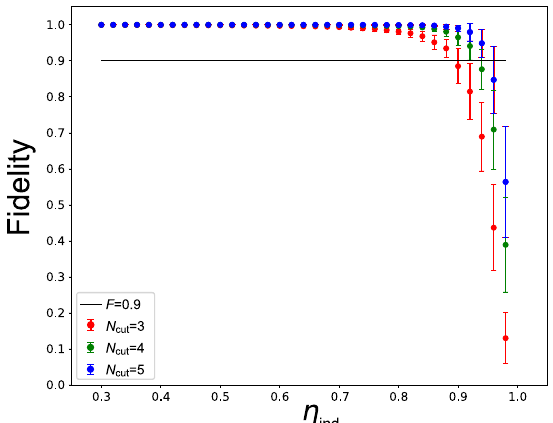
Fig. 2 Approximation fi delity with indistiguishability ef fi ciencies. Numerical evaluations of fi delity, Eq. (42), for N cut = 3, N cut = 4 and N cut = 5 when K = 35, M = 6, N = 6, r = 0.9, η t = 0.9. The output pattern is s 1 = ... = s N = 1, s N + 1 = ... = s K = 0 the other choices of output pattern give similar results. This result is obtained over 94 Haar-random unitary matrices. The error bar represents the standard